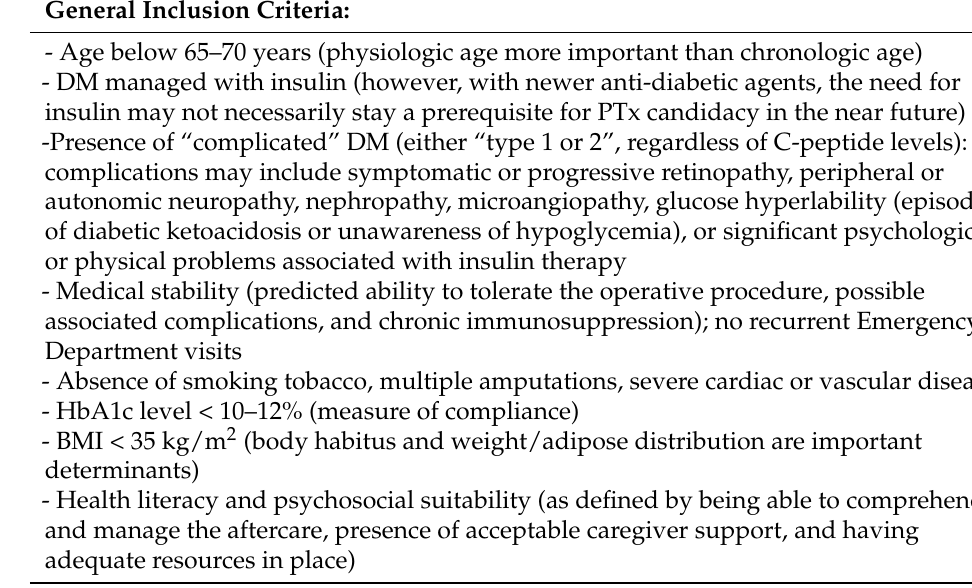
Table 1. Selection Criteria for PTx in Patients with either T1DM or